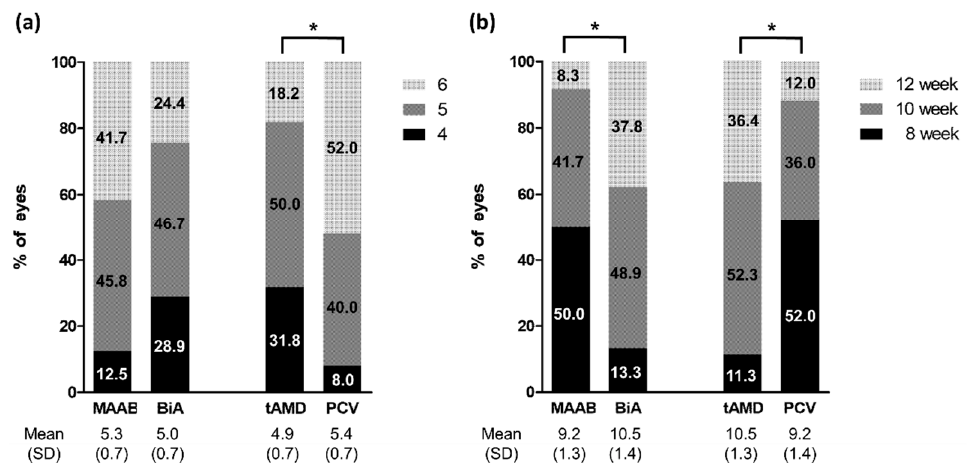
Figure 5. Number of aflibercept injections and last treatment interval in the second year. ( a ) Number of aflibercept injections during the second-year TAE/PRN period is not significantly different between the groups, but more injections are required in eyes with PCV than in those with typical AMD. ( b ) The treatment intervals are significantly extended in the BiA or typical AMD groups than in the MAAB or PCV groups. * p < 0.05 by chi-square test. Table 3. Number and interval of injections in the second year.